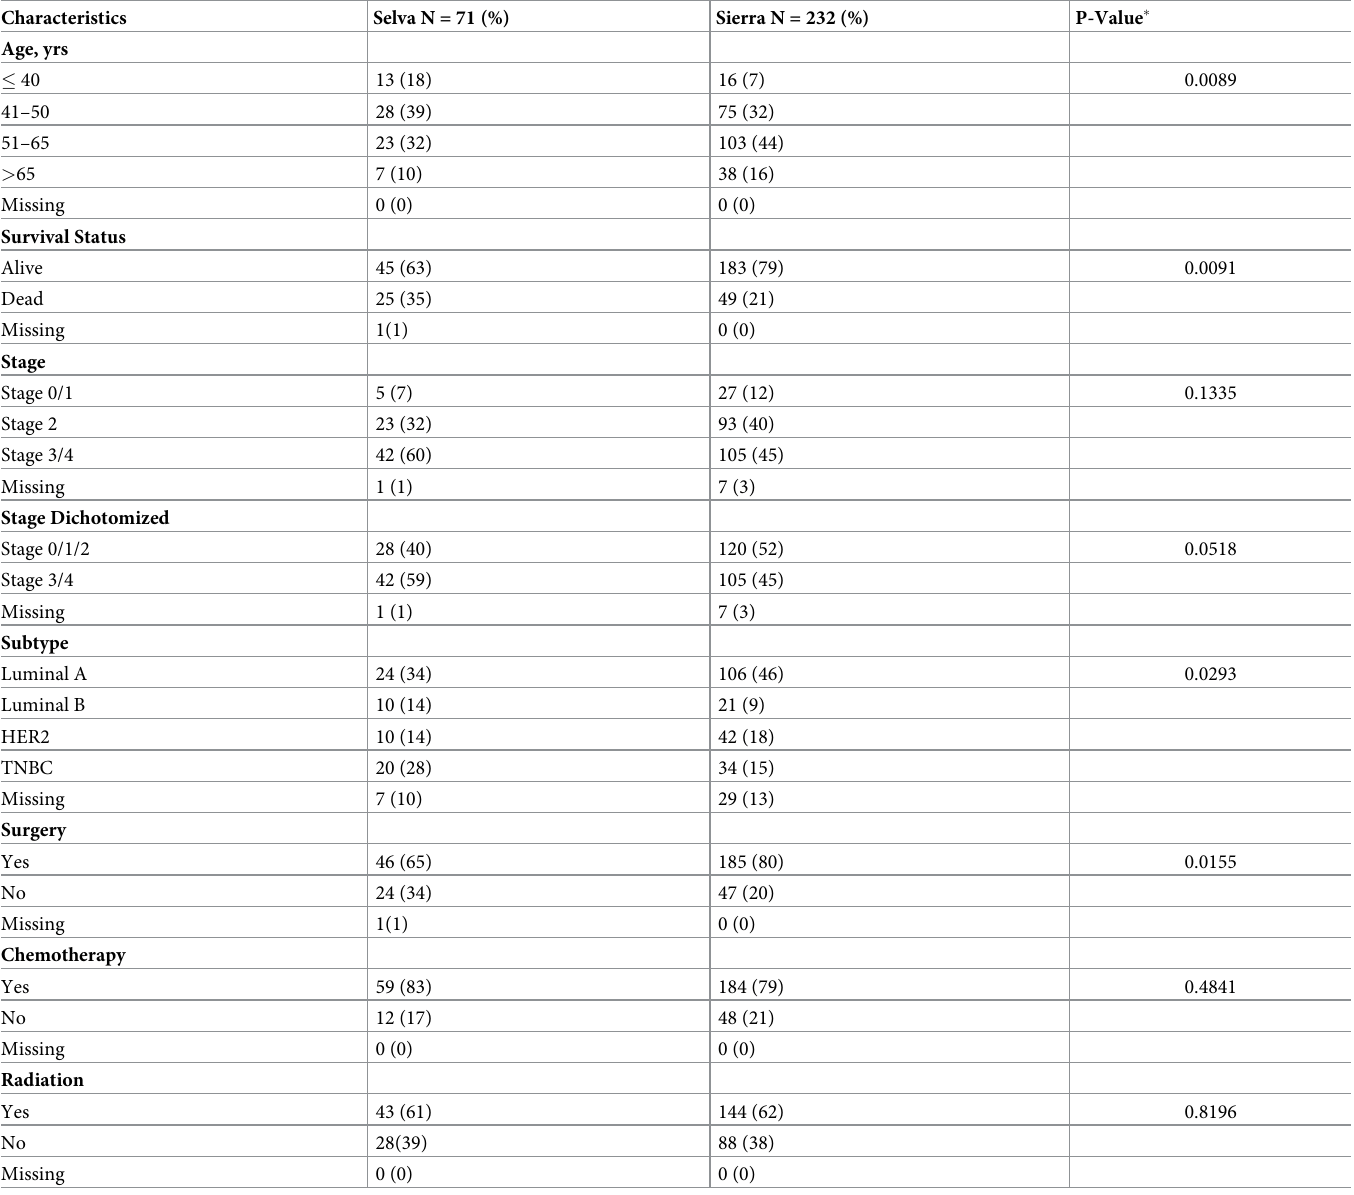
Table 1. Patient and tumor characteristics among woman from the “Sierra” and “Selva” regions of Peru, 2010–2015.